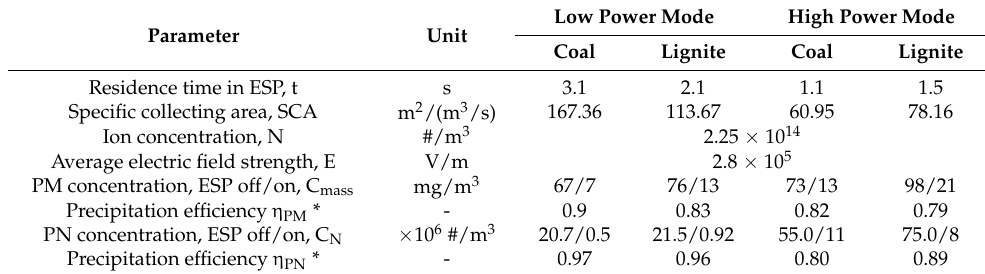
Table 4. Averaged experimental parameters of the ESP for specific regimes. Low Power Parameter Unit